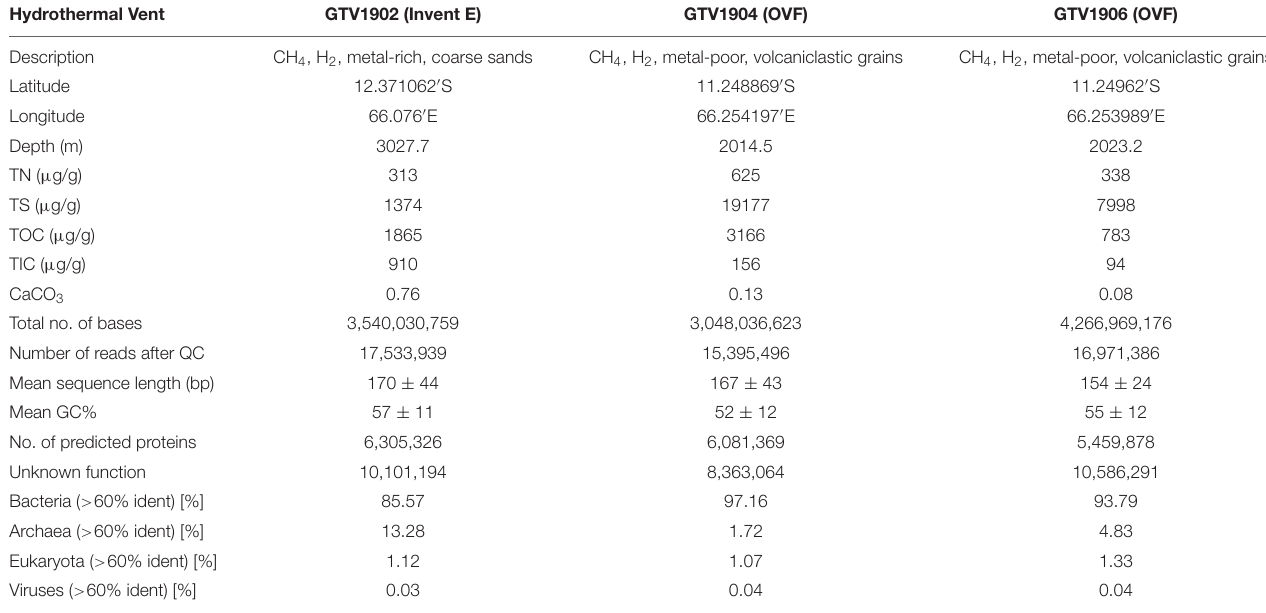
TABLE 1 | Sampling information, physico-chemical characteristics of samples, and summary statistics of the three metagenomes studied obtained from MG-RAST. Hydrothermal